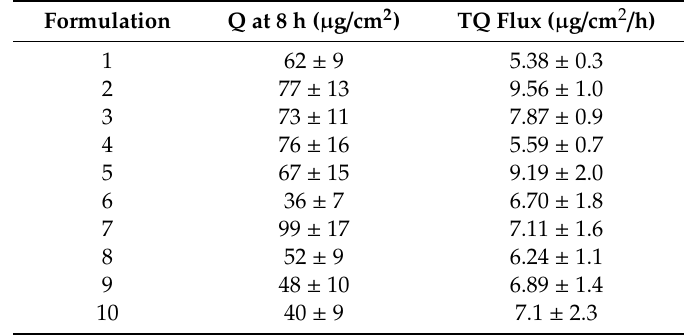
Table 3. Penetration parameters of thymoquinone through human cadaver skin ( n = 5) after 8 h. Formulation